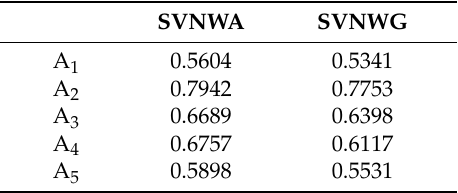
Table 2. The score functions of the emerging technology enterprises.